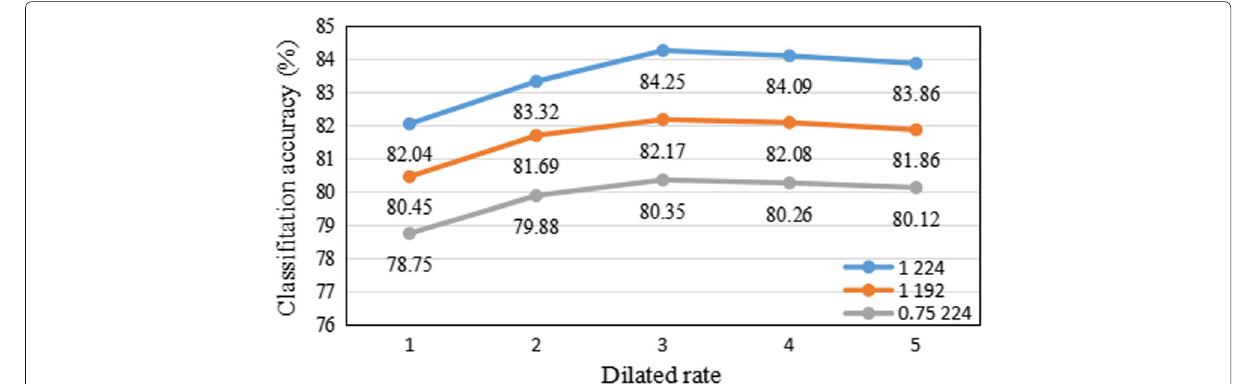
Fig. 7 Accuracy after hyperparameter